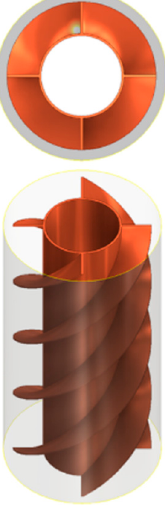
Figure 7. LHTES unit with multiple parallel spiral fins [63]. (Permission to reproduce from Ref.